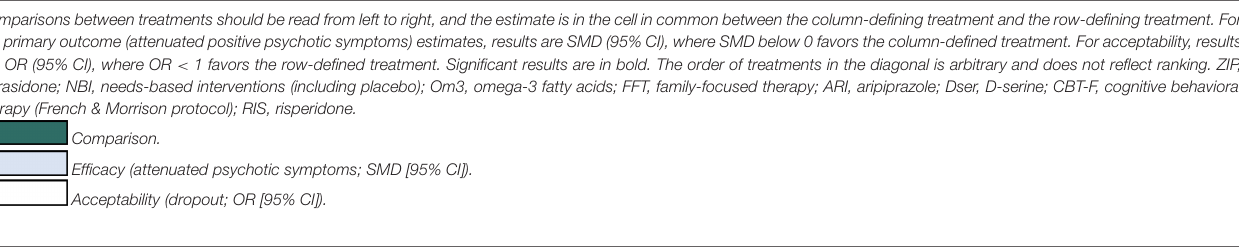
TABLE 4 | Network meta-analytic relative treatment effects for efficacy and acceptability at 12 months. OLA + NBI